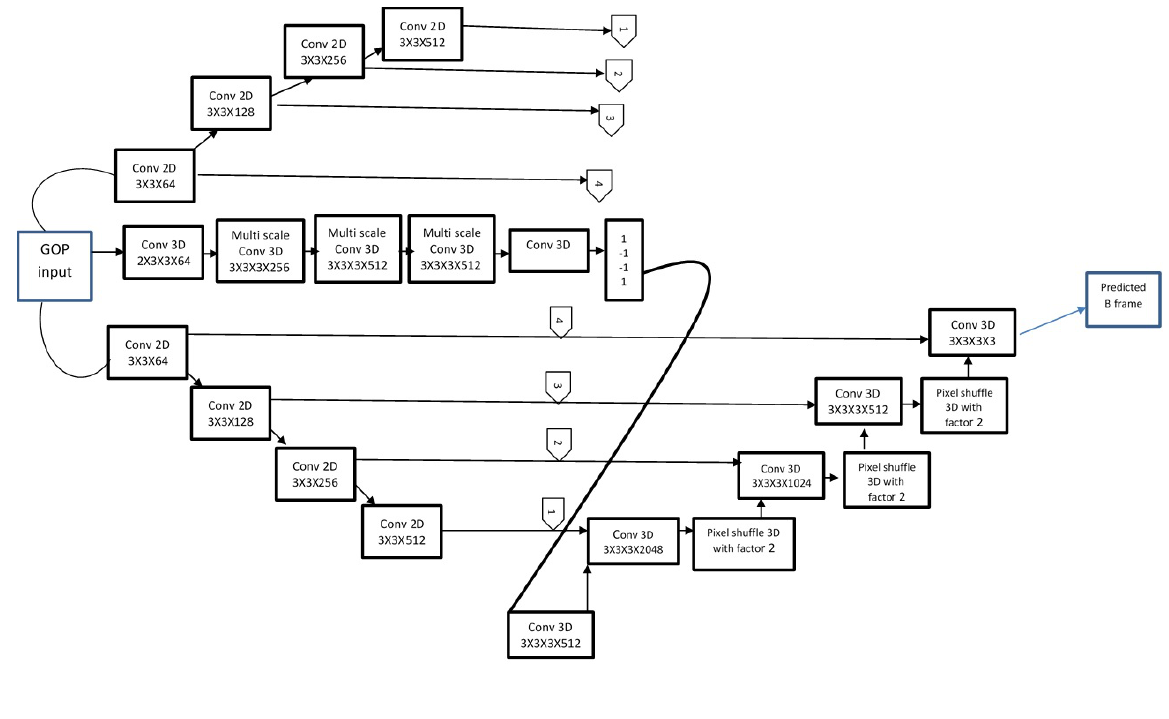
Fig. 6. The model of Deep CNN